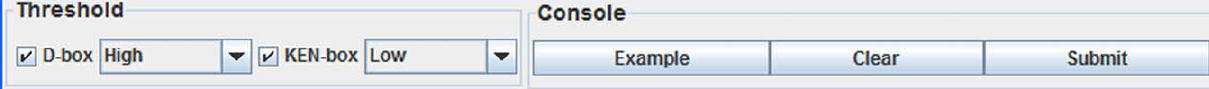
Figure 2. Screen snapshot of the GPS-ARM 1.0 software. The default thresholds were chosen for the D-box (high) and KEN-box (low). As an example, the prediction results for the human centromere protein F/CENP-F (UniProt ID: P49454) are shown.